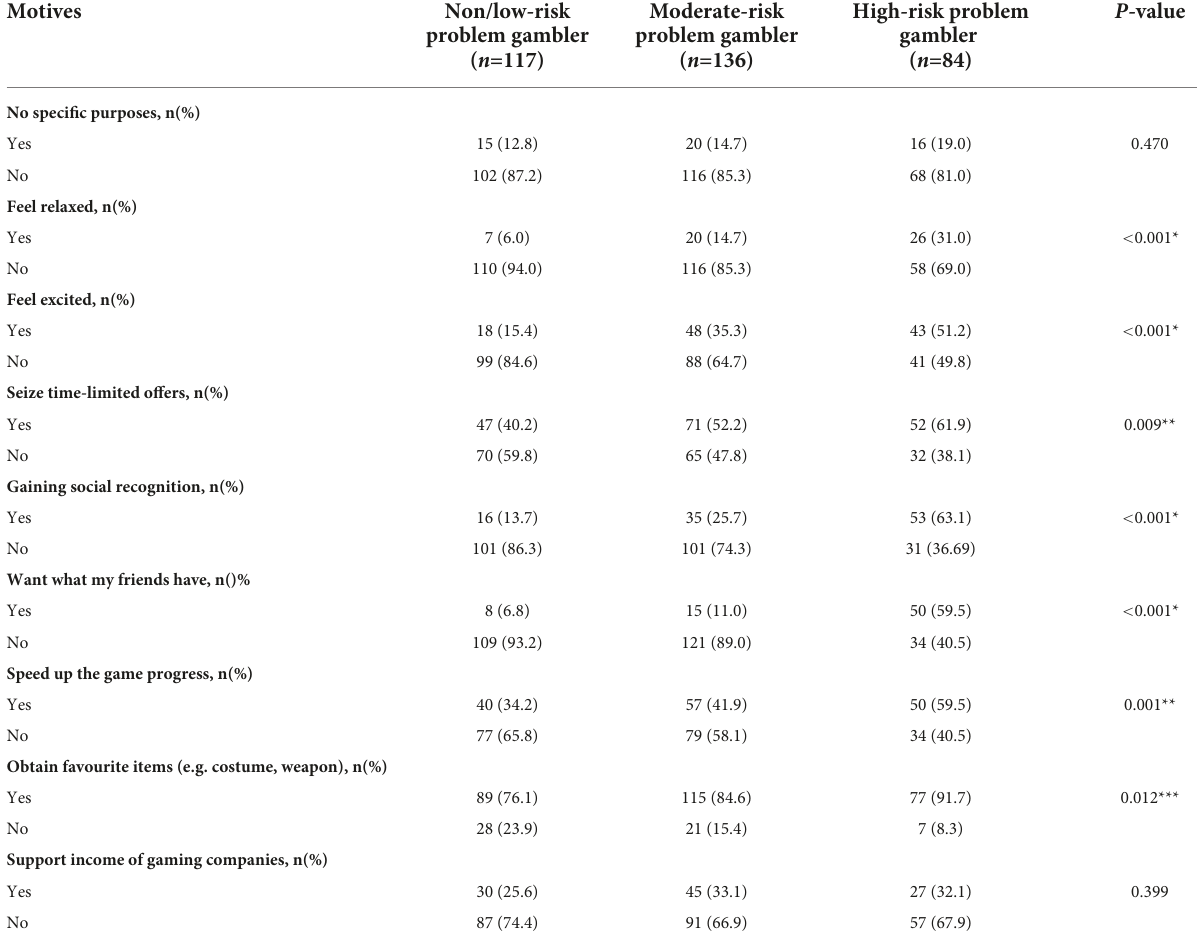
TABLE 2 Comparison of motives for gacha purchase among three levels of problem gambling.